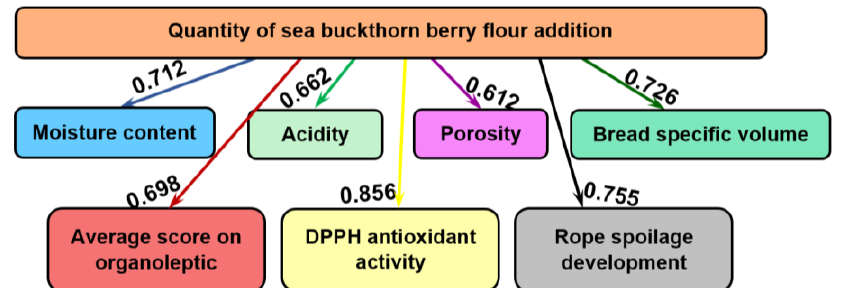
Figure 2. The informational analysis regarding the influence of various quantities of sea buckthorn berry flour on wheat bread physicochemical and organoleptic parameters, DPPH antioxidant activity and rope spoilage development.